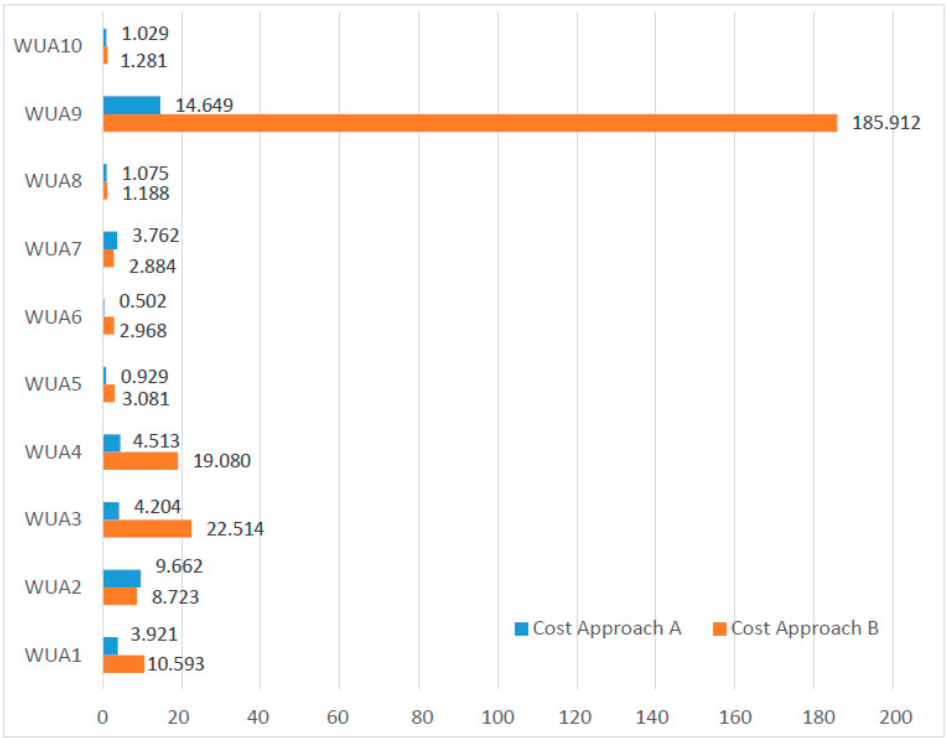
Figure 4. Approaches A and B, costs GHG emissions (M€/tCO 2 ).